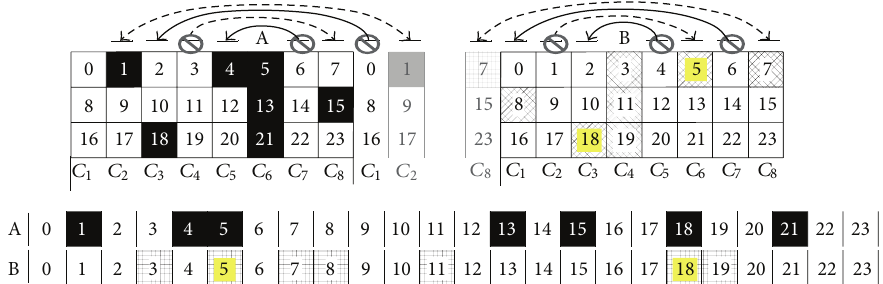
Figure 3: Example of mirror torus QS: 𝐴 and 𝐵 initiate their tail selection in a backward manner; that is, the first element of node A is selected from column 𝐶 5 (a mirror of 𝐶 7 ), and the one of node 𝐵 is selected from column 𝐶 3 (a mirror of 𝐶 5 ). Then, both nodes select the next tail element in a forward manner, thus from 𝐶 𝑗+2 column, which is 𝐶 8 in case of node 𝐴 , and 𝐶 6 in case of node B. The third tail element is selected in a backward manner, which is 𝐶 3 in case of node 𝐴 , and 𝐶 1 in case of node 𝐵 . The last element of nodes 𝐴 and 𝐵 falls in the same (mirror) column. Nodes meet at slot 5 (they would meet in one element of column 𝐶 6 anyway) and additionally in slot 18. Hence, nodes can always alternate the manner, either forward or backward, while picking up elements; however, they need to have the same 𝑘 𝑖 , in this example = {−1,1, −1,{1 | −1}} , where 𝑖 = 1 ⋅⋅ ⋅⌊8/2⌋ 𝑘 𝑖